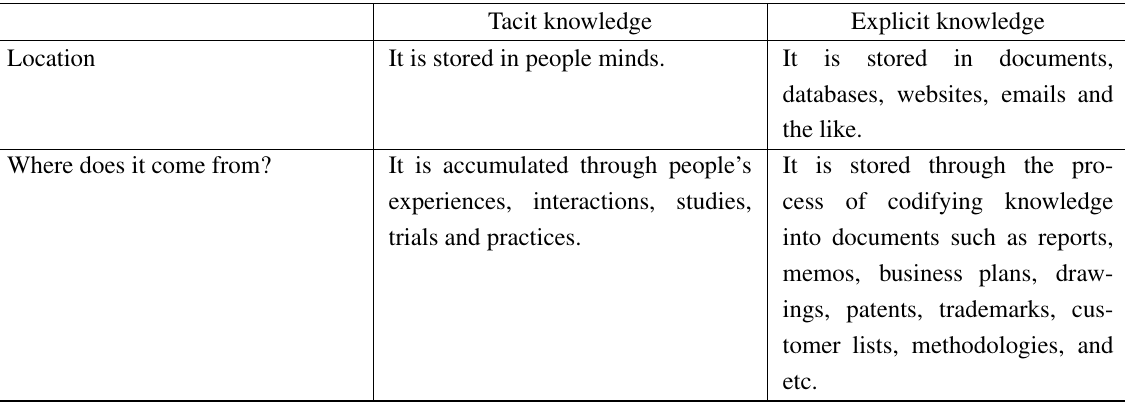
Table 6. Tacit and Explicit